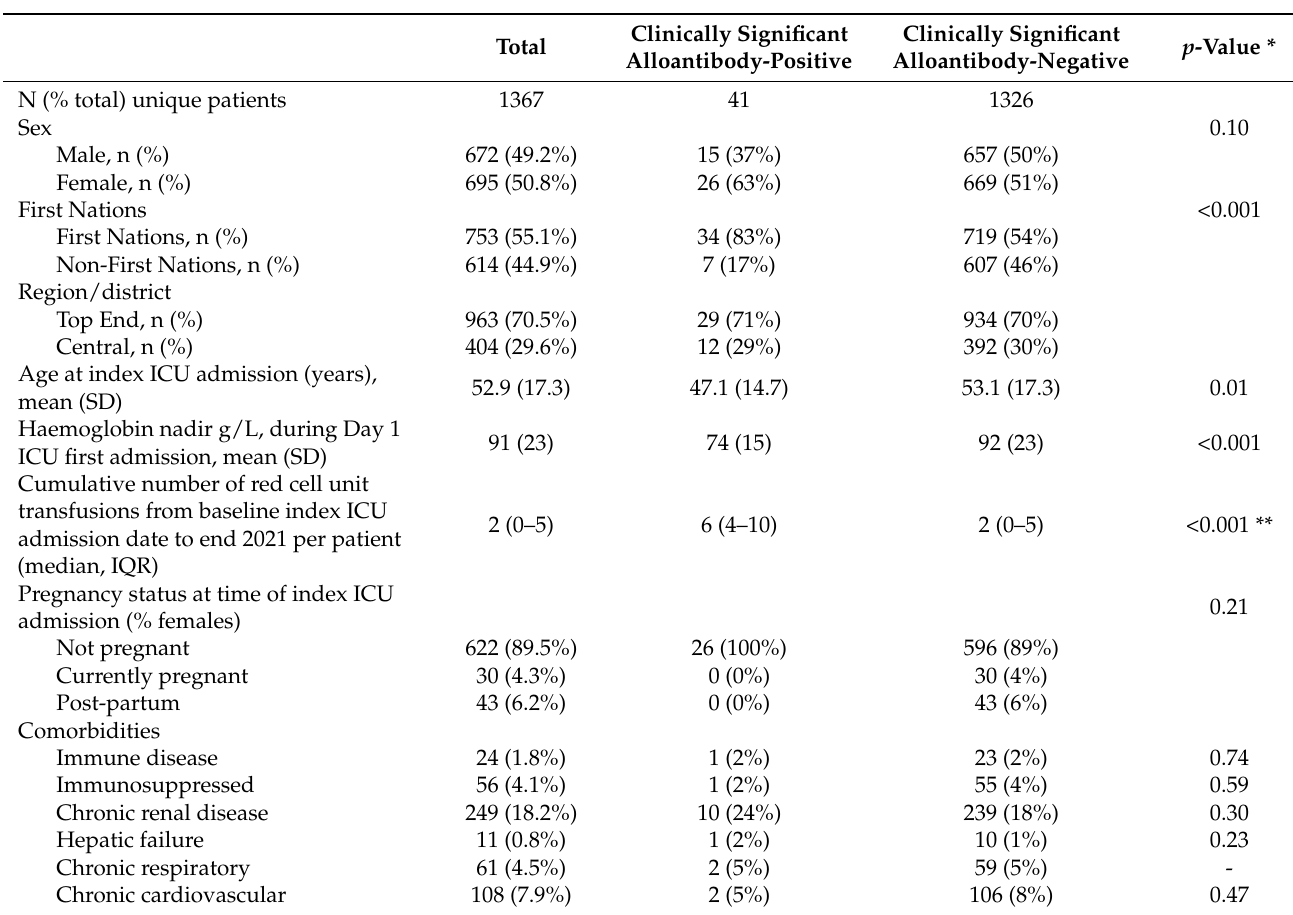
Table 5. Characteristics of patients at time of index ICU admission in NT public hospitals during the study period (2015–2019), for patients with both a baseline and follow-up RC alloantibody screen performed, categorised by new incident clinically significant RC alloantibody status. Clinically Total